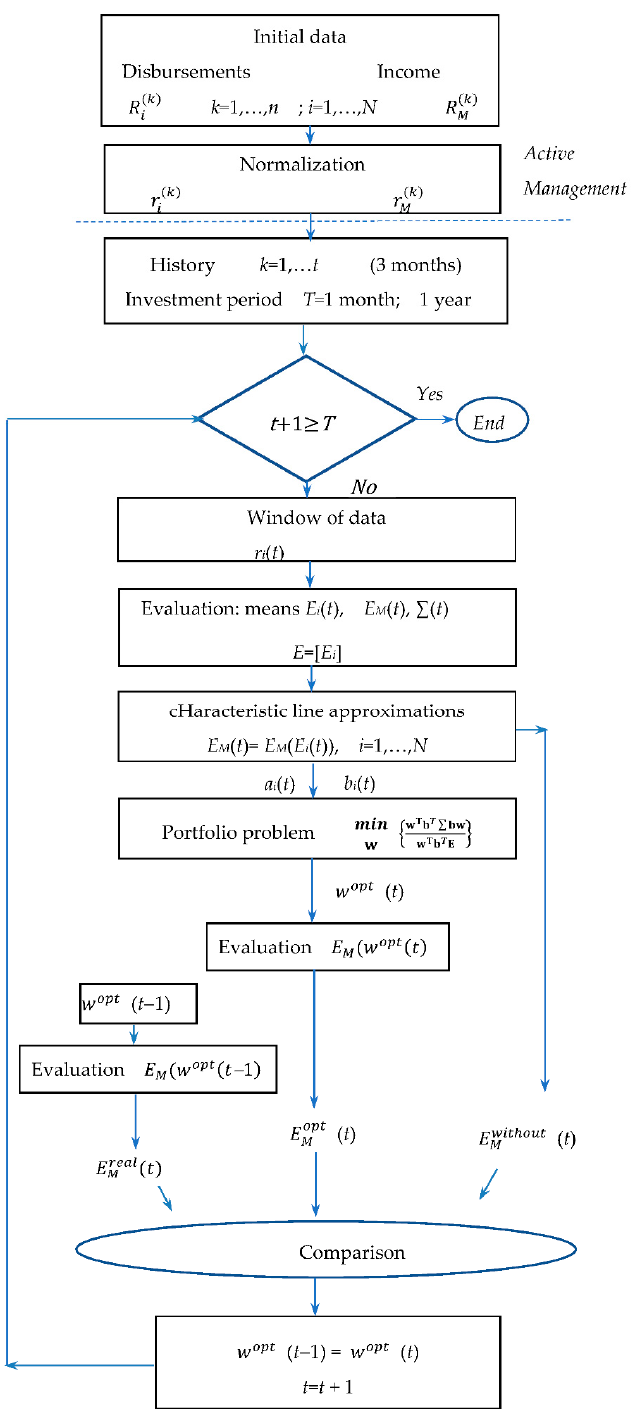
Figure 7. Flow chart diagram of active business